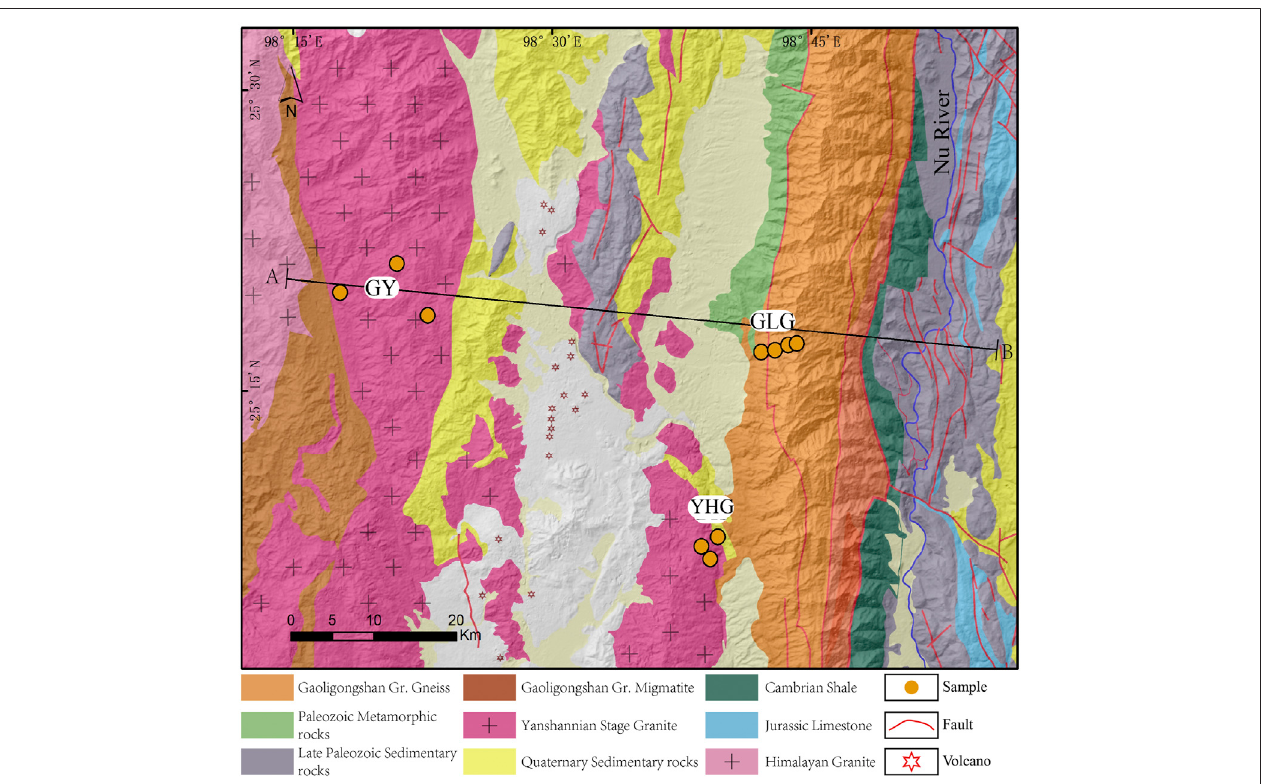
FIGURE 2 | Simpli fi ed geological map superimposed on shaded relief of the Tengchong area. Locations of samples collected for this study are shown.